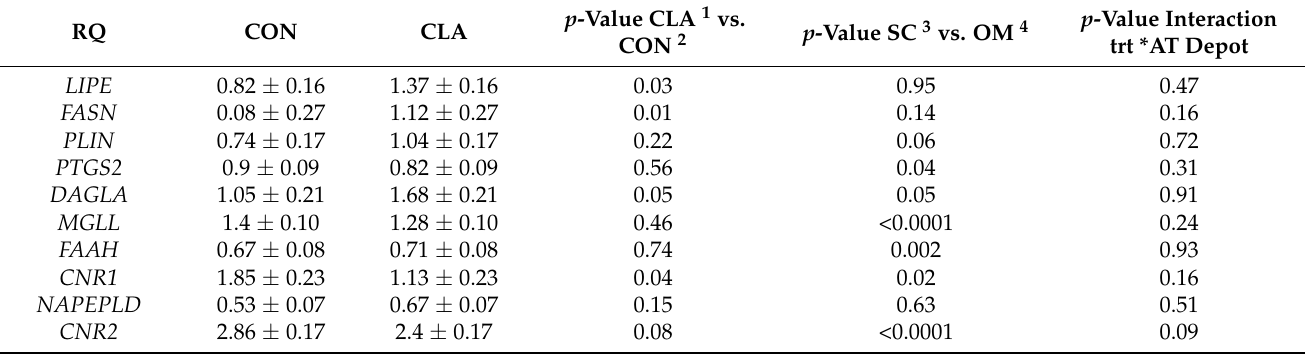
Table 3. Average relative gene expression in CON and CLA AT from cows.